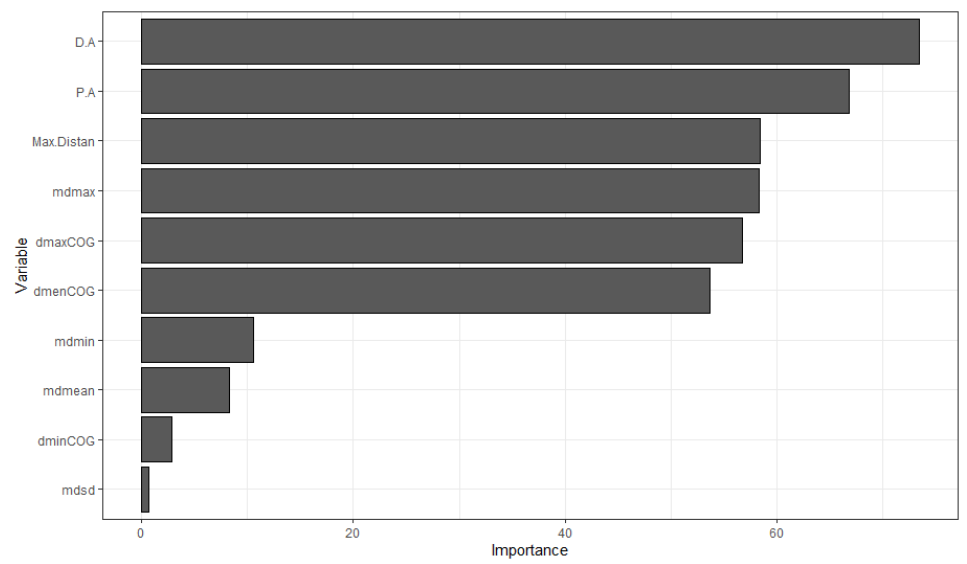
Figure 10. Variables ’ importance according to the decision-tree algorithm implemented through the library rpart [61]. Variables with importances ’ smaller than 1% were omitted.